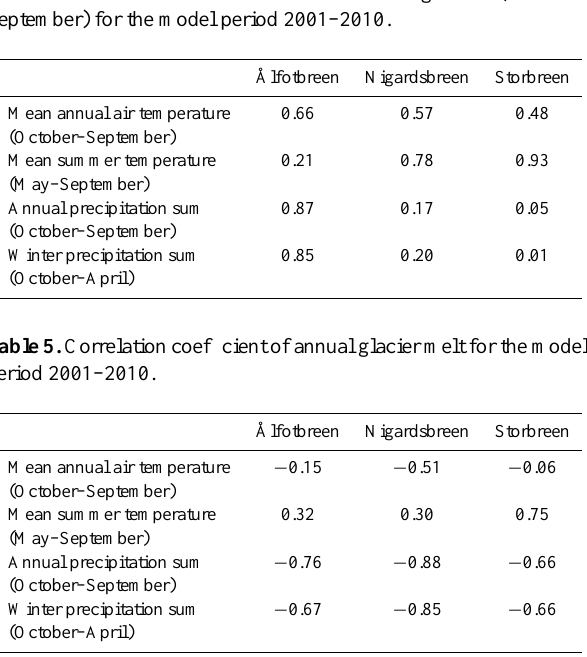
Table 4. Correlation coefficient of annual discharge sums (October– September) for the model period 2001–2010.